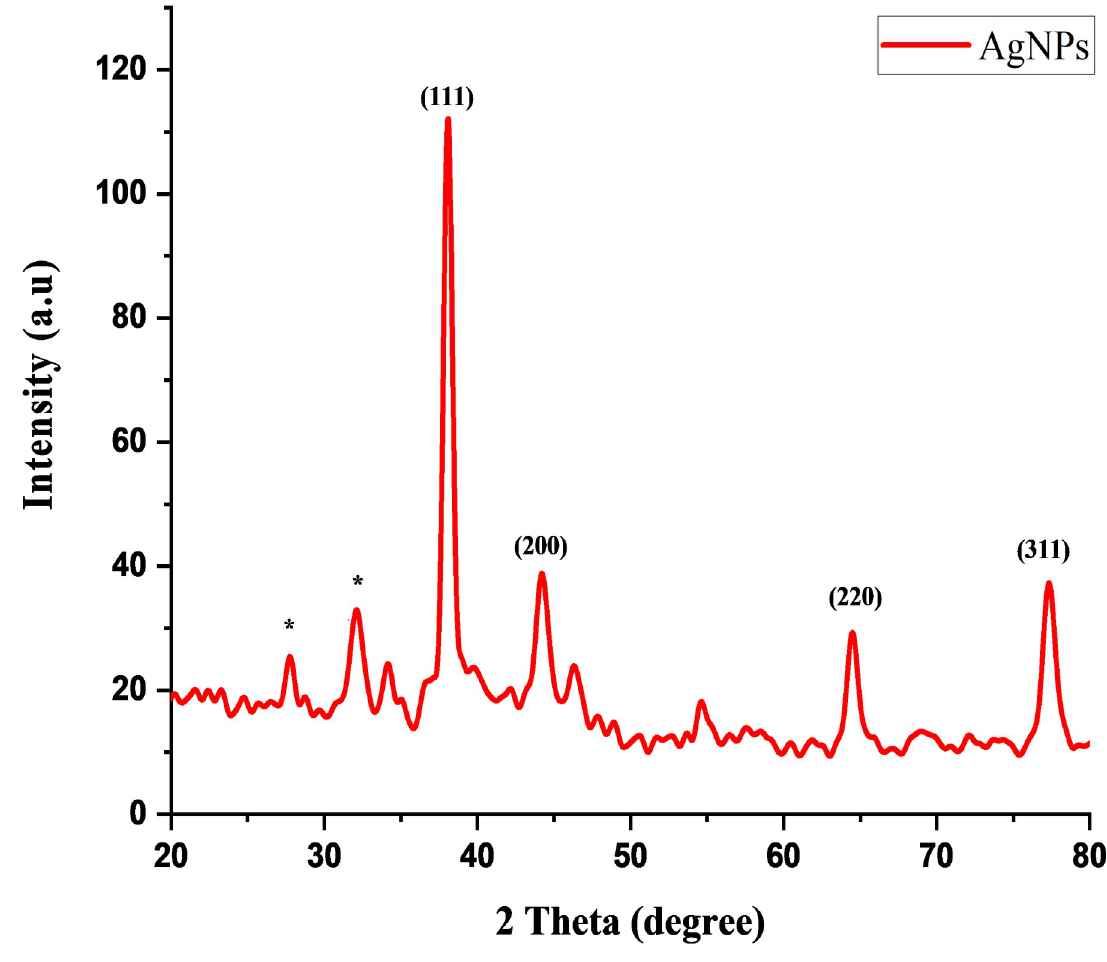
Fig 4. XRD analysis of green synthesized AgNPs. Effect of AgNPs on banana color. Color is the most important criterion to determine the quality of fresh fruit. The surface color of banana, which changes from green to yellow as the fruit ripens, is one of the key elements to study the quality and market value of fruit [38]. All the samples of banana treated with different levels of AgNPs (T1 = 0.01, T2 = 0.02, T3 = 0.03, T4 = 0.04 and T5 = 0.05%) resulted the least change in banana color as compared to control banana samples. The untreated banana samples reached to fully ripened stage within 14 days of storage period and it may be due to degradation of green pigment chlorophyll that is replaced by new pigments like carotenoids, microbial growth and more ripening due to ethyl- ene production [52] and the samples treated with AgNPs reduced the postharvest losses till 32 days at 25˚C. Among all concentrations, bananas treated with 0.01% (T1) of AgNPs showed the lowest score (3.00) of peel color with more greenish shade at 32 days of storage while untreated bananas got the highest score of 7.00 at 21 days and score 8.00 at 28 days of storage (Fig 10). The results are consistent with previous reports that AgNPs from citrus peel extract delayed the color development in different fruits and vegetables at 0.1% concentration of neem-AgNPs that delayed the color of banana by minimizing the microbial attack [53]. Simi- larly, AgNPs from marigold flower and lemon peel extract improved the shelf life of berries